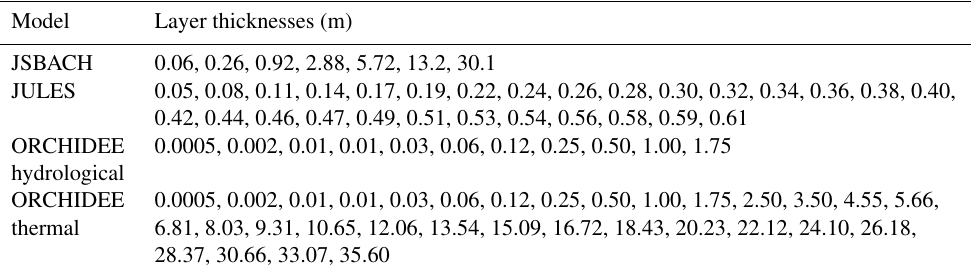
Table A2. Soil layer thicknesses in the